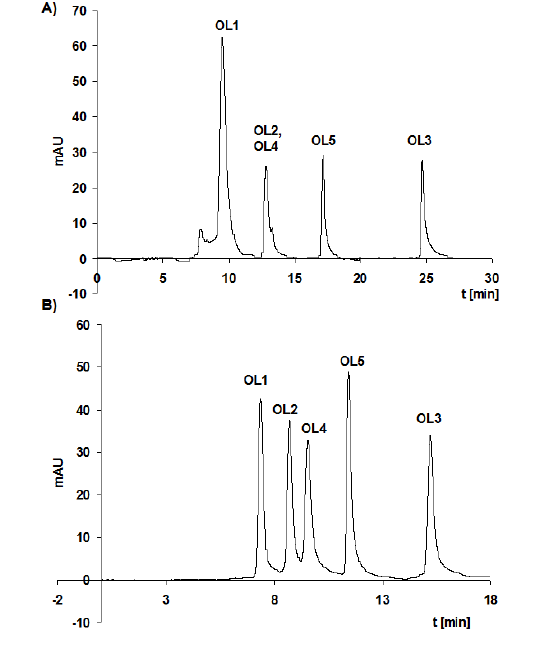
Figure 4: Results of oligonucleotides separation with the use of alkylamide stationary phase. Chromatographic conditions: